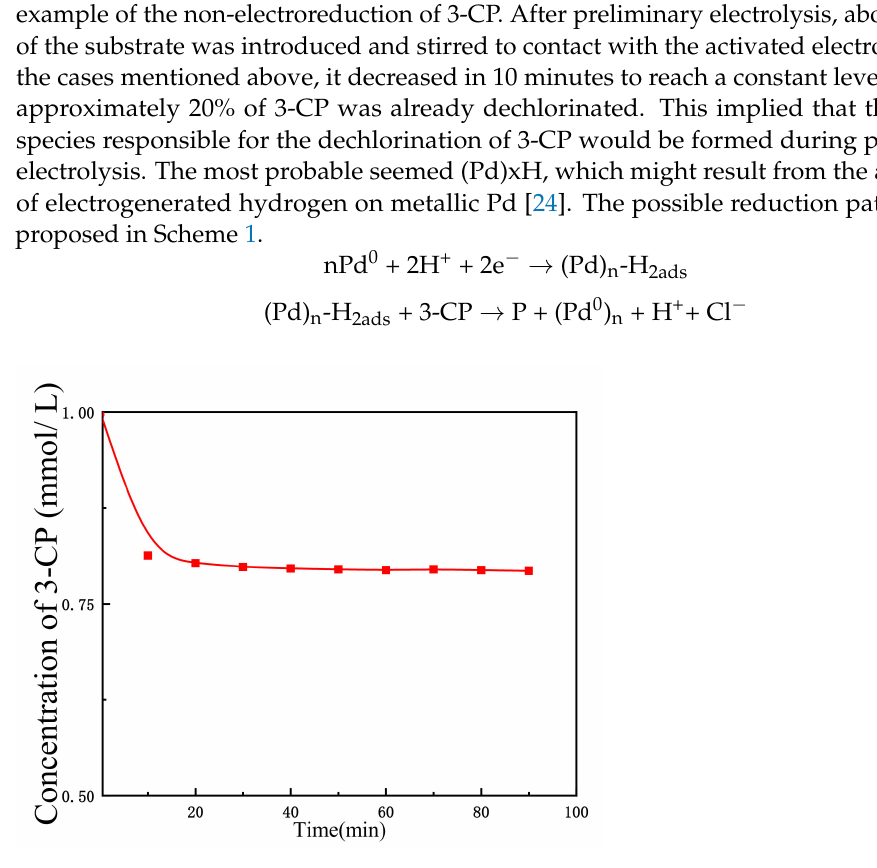
Figure 14. The variation of 3-CP in non-electrolytic dechlorination after preliminary